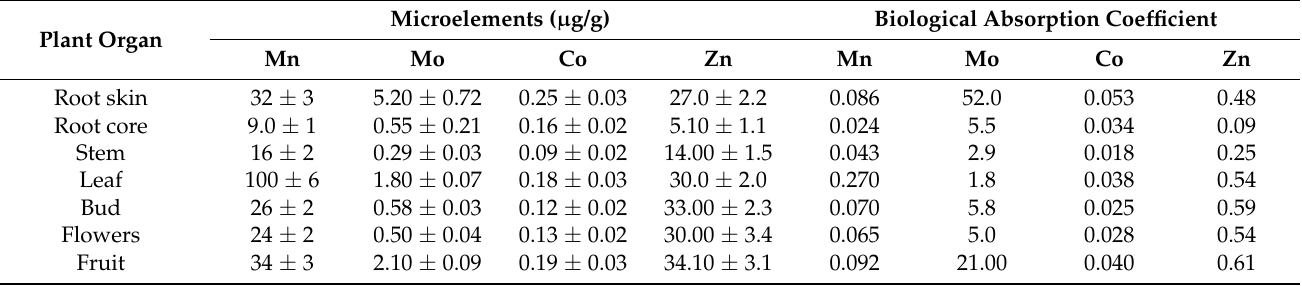
Table 5. The amount of micronutrients in the organs of C. spinosa L. ( µ g/g) and the coefficient of biological absorption, ( n = 14).